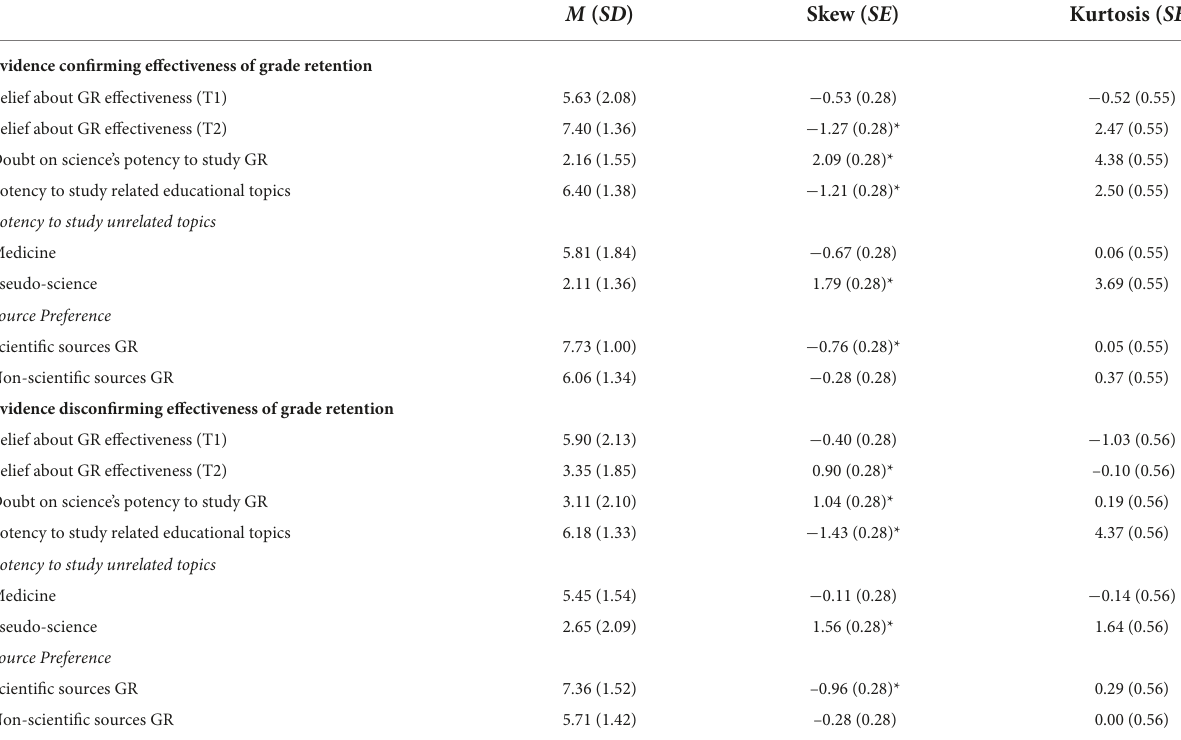
TABLE 1 Study 1: Descriptive statistics by evidence condition.